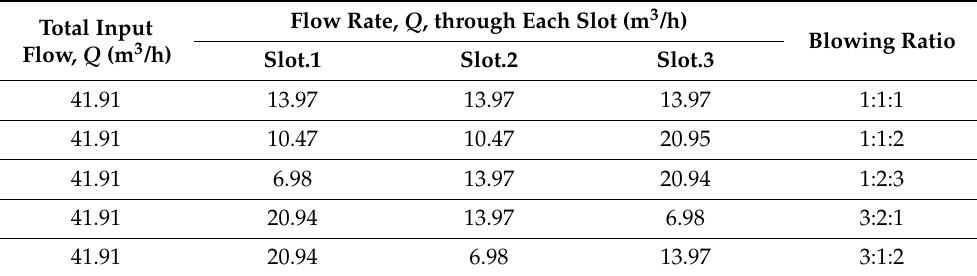
Table 5. Experimental parameters of different blowing proportions. Total Input Flow, Q (m 3